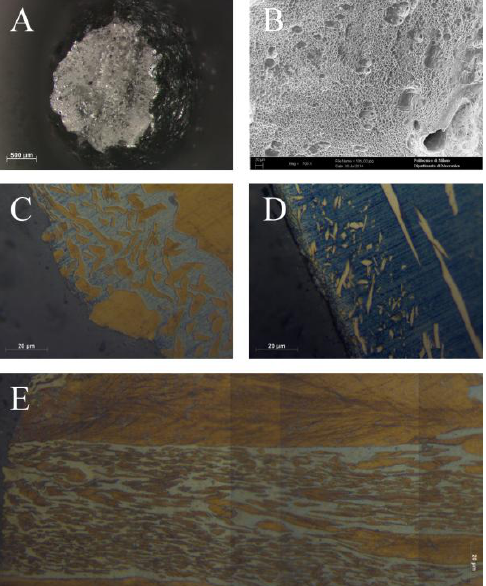
Figure 3. Post-mortem analysis of the tensile samples: stereoscopy morphological imaging of the sample annealing treated for 355 s/mm ( A ), SEM/SE morphological imaging of the specimen annealing treated for 710 s/mm ( B ), optical micrography of the fracture surface section of the specimen annealing treated for 1135 s/mm ( C ), optical micrography of the fracture surface section of the sample annealing treated just solution heat treated ( D ), and optical micrography of the fracture surface section of the specimen annealing treated for 36 s/mm ( E ).